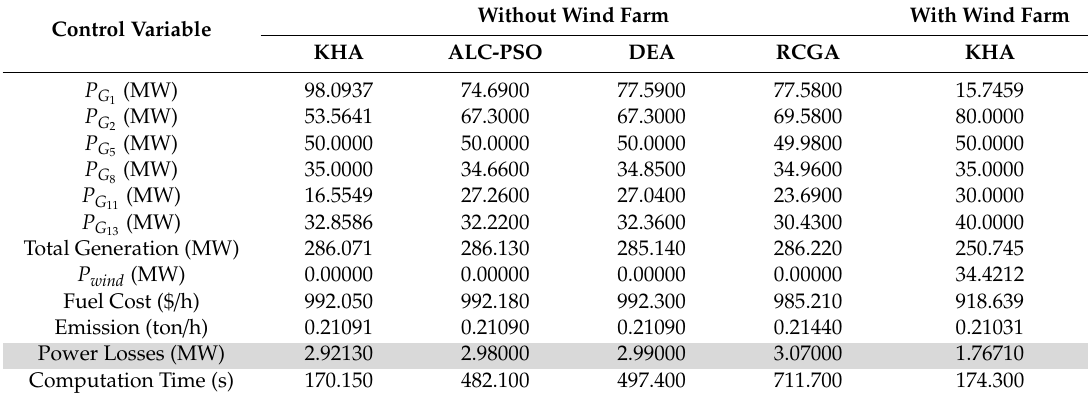
Table 5. Results for minimizing the active power losses across the transmission lines for the Test System 1.